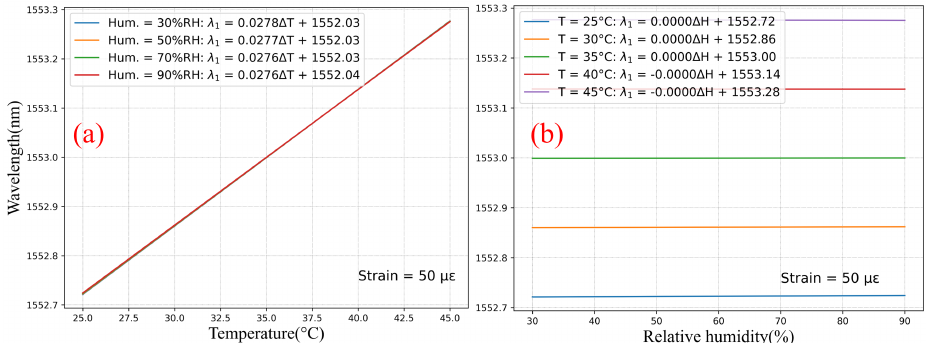
Figure 8. Computation of the CYTOP-FBGs without over-clad (FBG #2) response to ( a ) temperature and ( b ) humidity within fixed strain